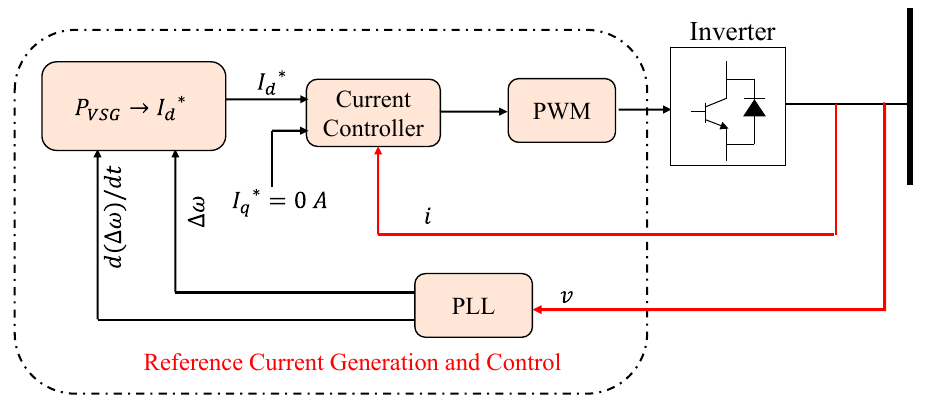
Figure 13. Virtual-synchronous generator (VSG) topology [18].